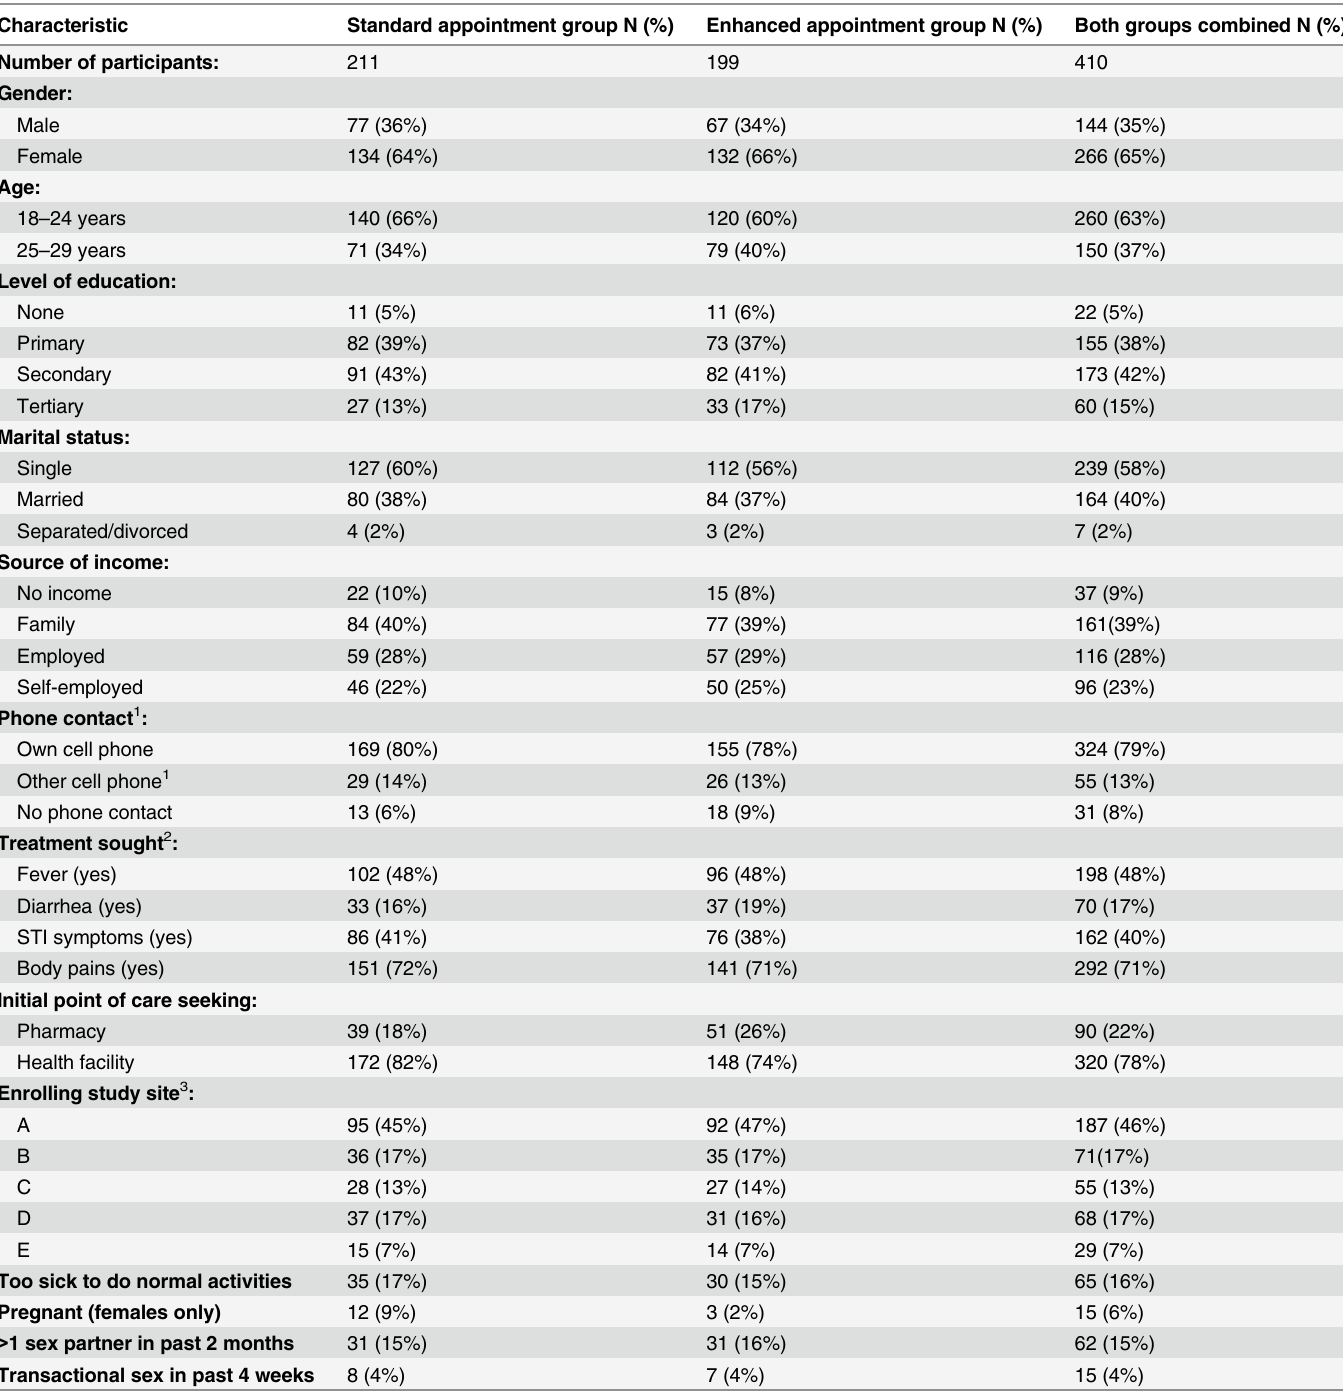
Table 1. Baseline characteristics of